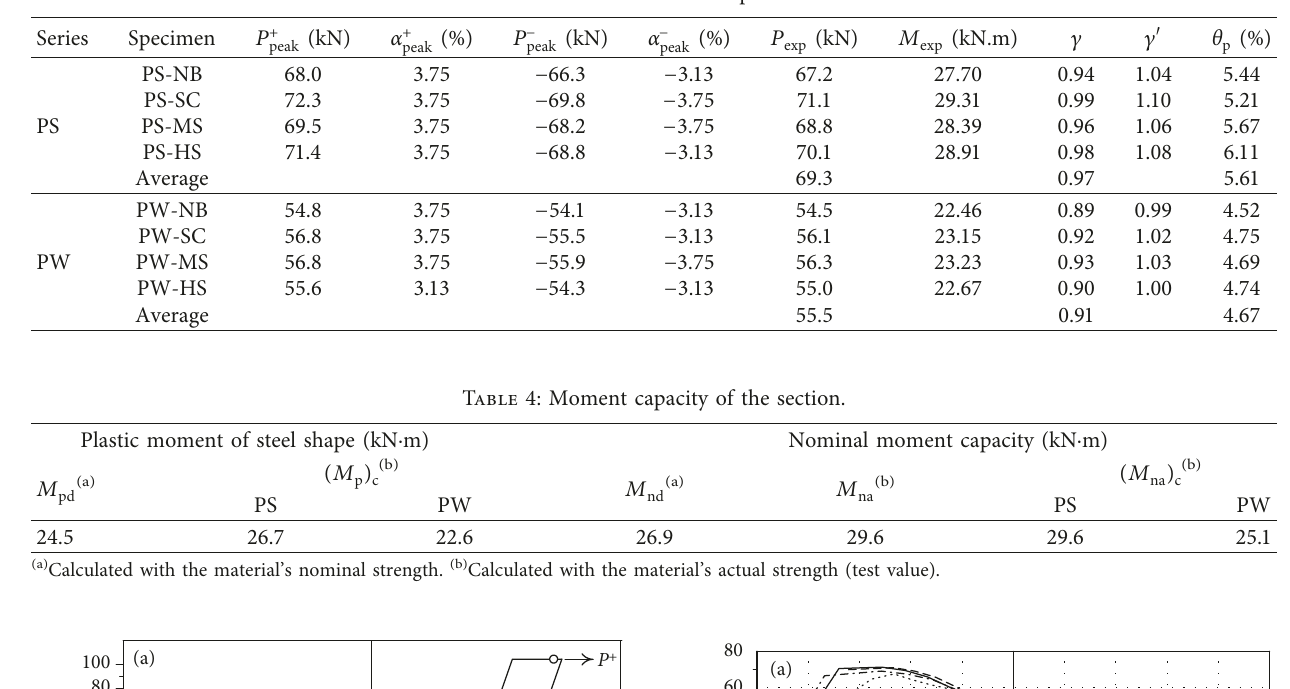
). L Figure 14: Skeleton curve of plastic hinge rotation for PS series.